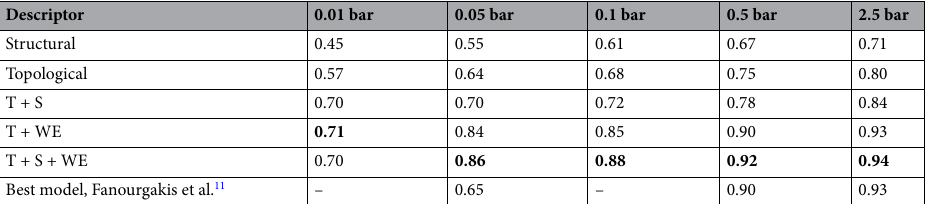
Table 1. Summary of model performances for hMOF dataset and CO 2 adsorption. Machine learning results for carbon dioxide adsorption predictions on the hMOF dataset at different pressures, represented by R 2 score. The best performing model for a given pressure is highlighted.